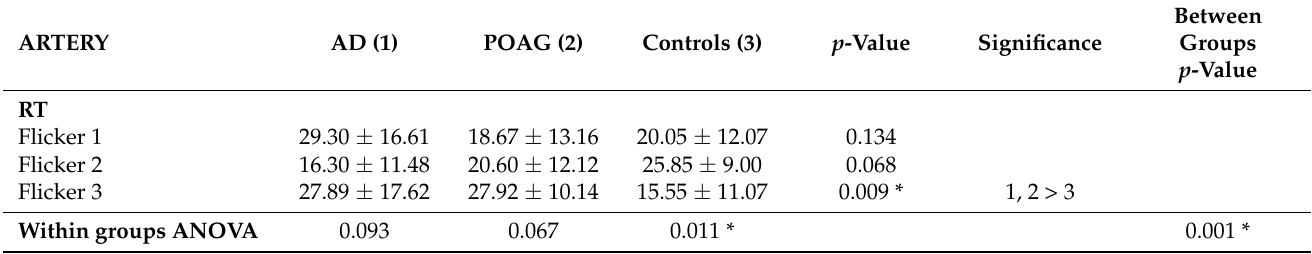
Table 3. Arterial Reaction Time by Flicker